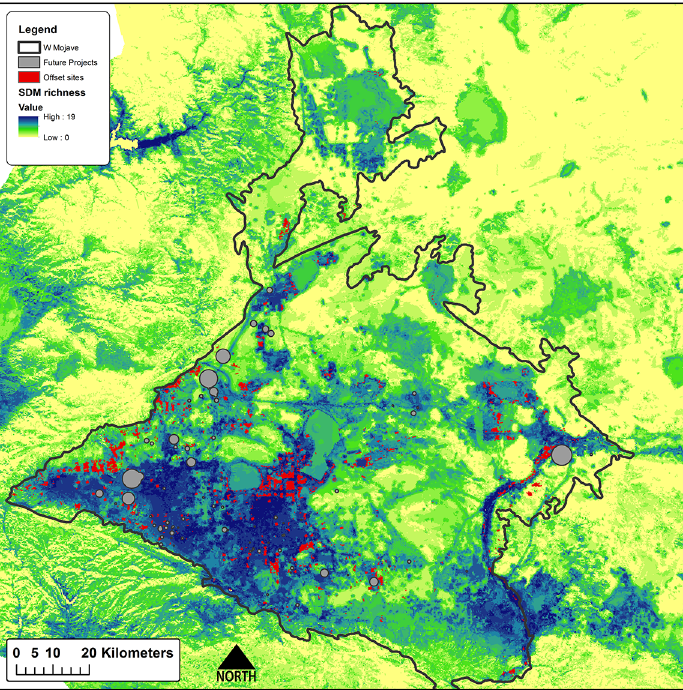
Fig 4. Direct offset sites. Direct offset sites (red) for hypothetical solar energy projects (gray) using a 2:1 offset ratio, over modeled species richness.